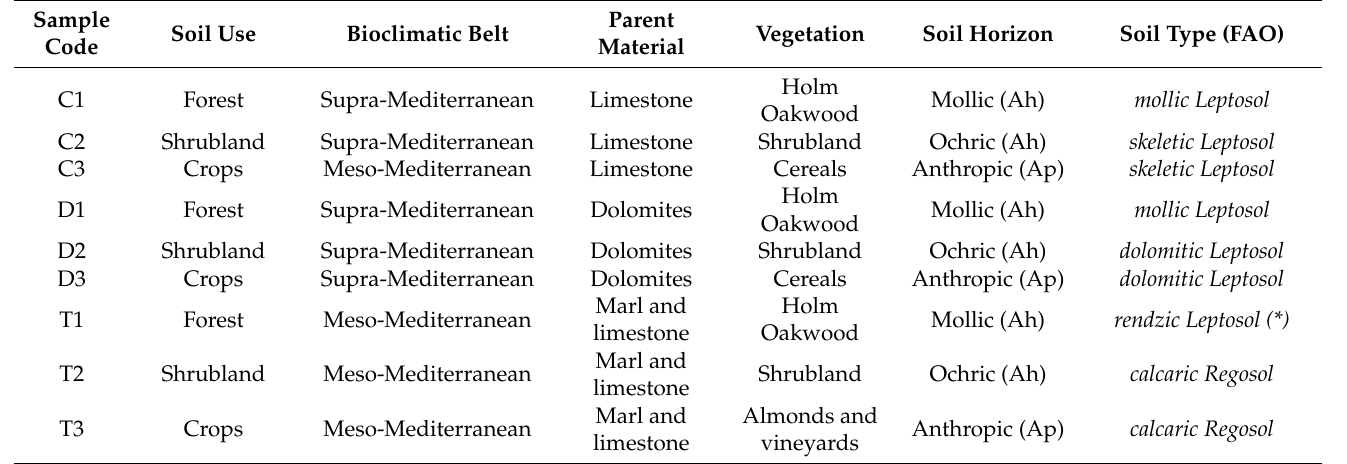
Table 1. Summary of the studied soils showing their uses, soil formation factors, horizons, and